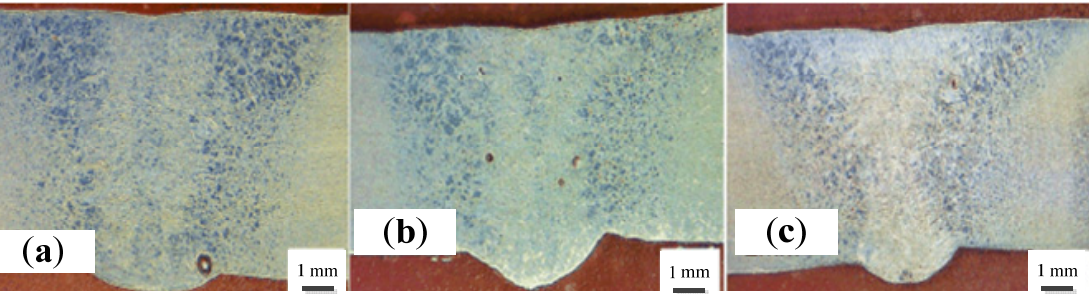
Figure 9. The cross-section morphology under different laser defocus: ( a ) − 2 mm, ( b ) 0 mm, ( c ) 2 mm.